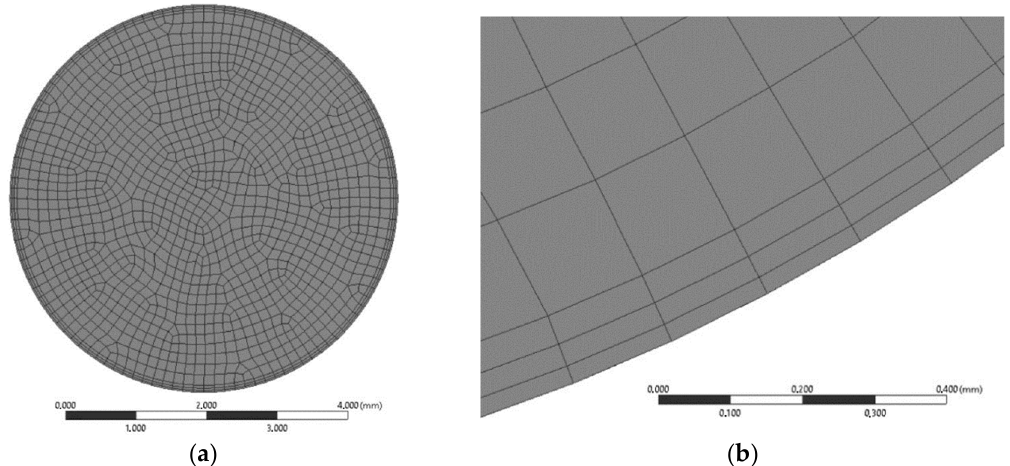
Figure 9. Details of the numerical mesh with ( a ) surface mesh of the wider tube-end and ( b ) boundary layer close to the wall.